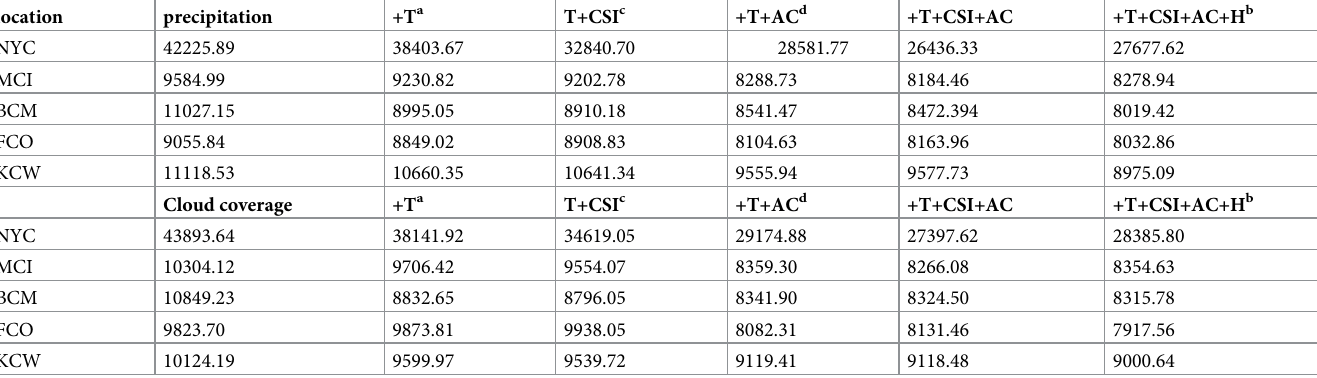
Table 4. QAIC values returned depending on integration of variables into the precipitation and cloud coverage models respectively.